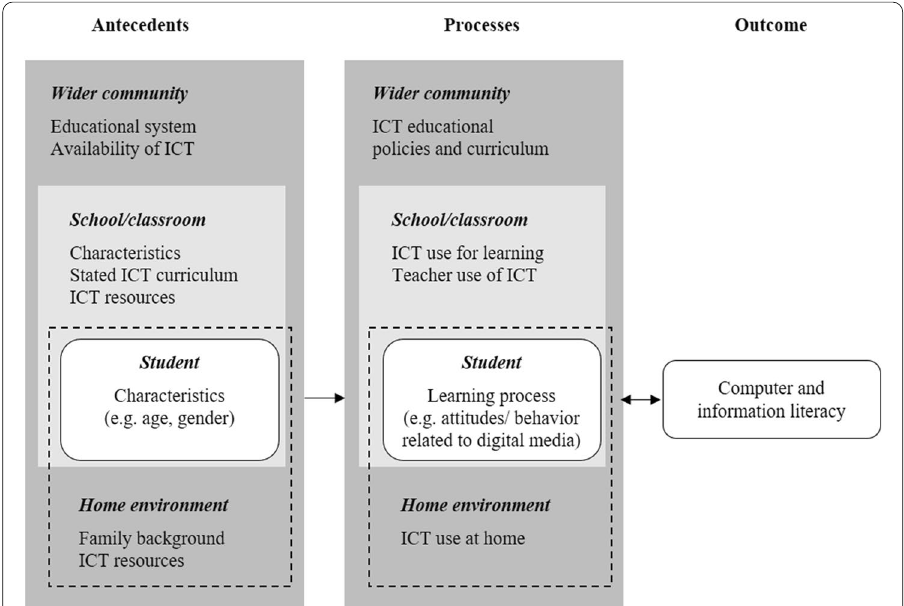
Fig. 1 Theoretical model of the acquisition of computer and information literacy ( adapted from Fraillon et al. 2020, p.